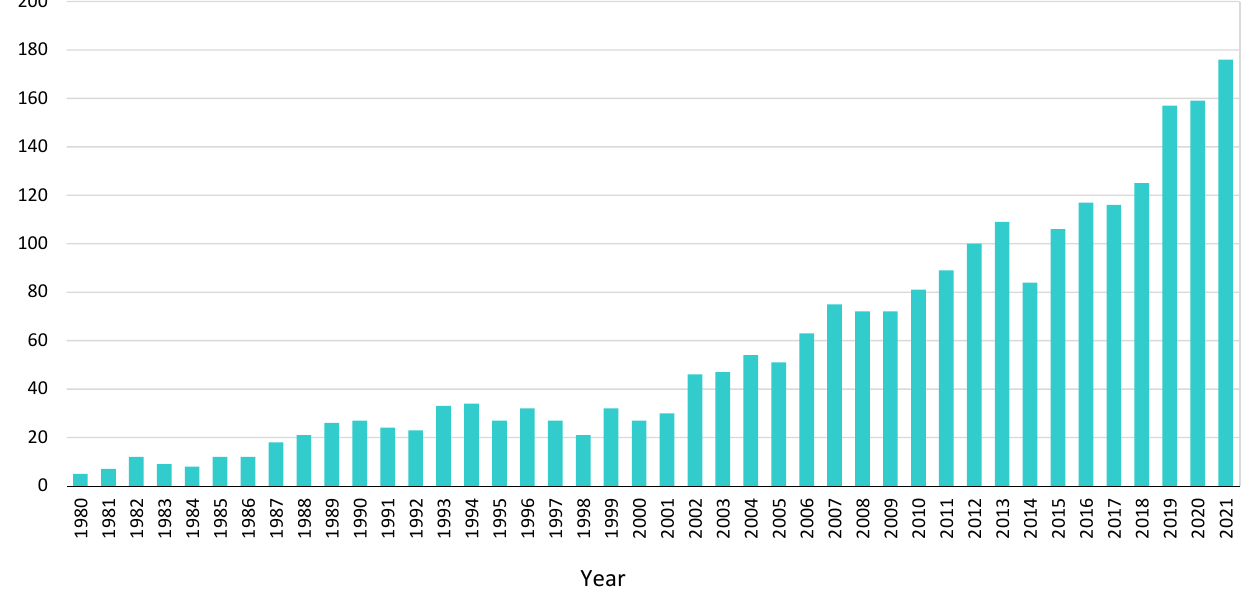
Figure 2. Number of yearly publications about coal microbiology.